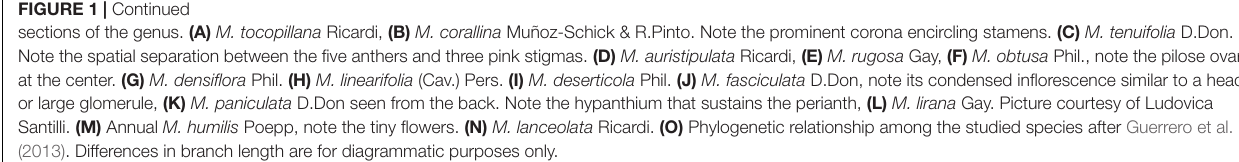
Frontiers in Ecology and Evolution |